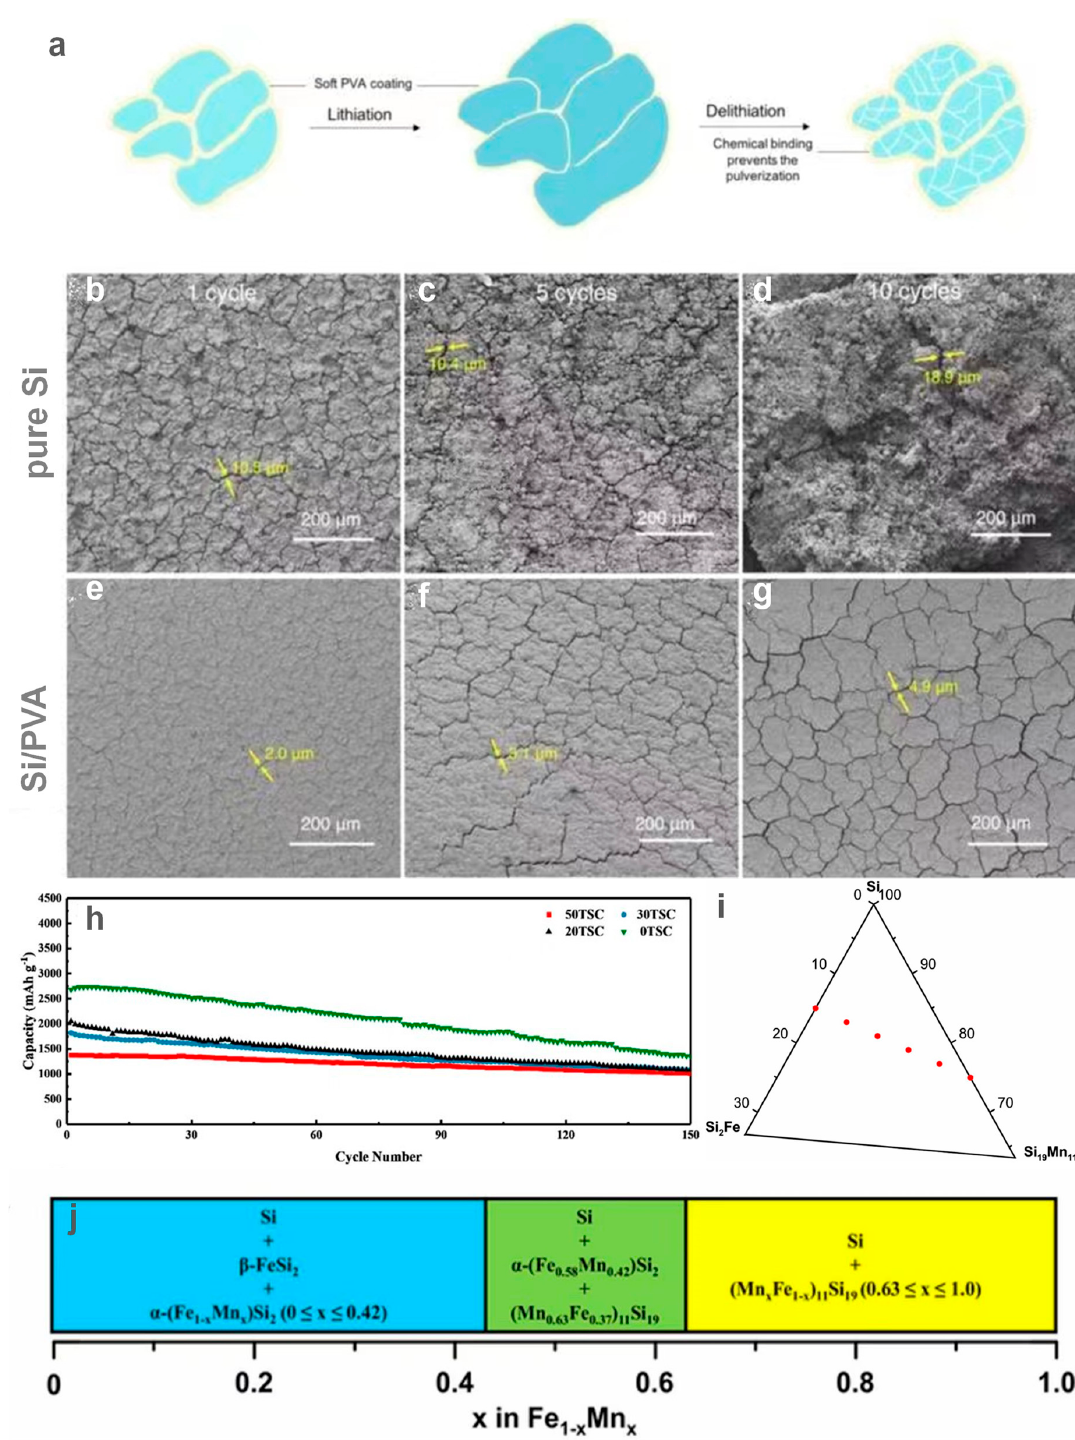
Figure 3. ( a ) Schematic diagram of the lithiation/delithiation process of the ball-milled silicon materials; morphology of cycled silicon electrodes. SEM images of ( b – d ) high-energy ball-milling (HEBM) Si electrodes and ( e – g ) reactive high-energy ball-milling (RBM) Si-5% PVA after ( b , e ) one, ( c , f ) five, and ( d , g ) 10 cycles, respectively. Reproduced with permission [64]. Copyright 2020, American Chemical Society. ( h ) Cyclic performance of Si/TSC with different mass ratios of TSC. Reproduced with permission [65]. Copyright 2019, Elsevier B. V. ( i ) Composition of ball-milled samples overlaid on a truncated Fe–MnSi ternary phase diagram. ( j ) The observed phase behavior during ball-milling compositions along the Si 85 Fe 15 –Si 75 Mn 25 tie line